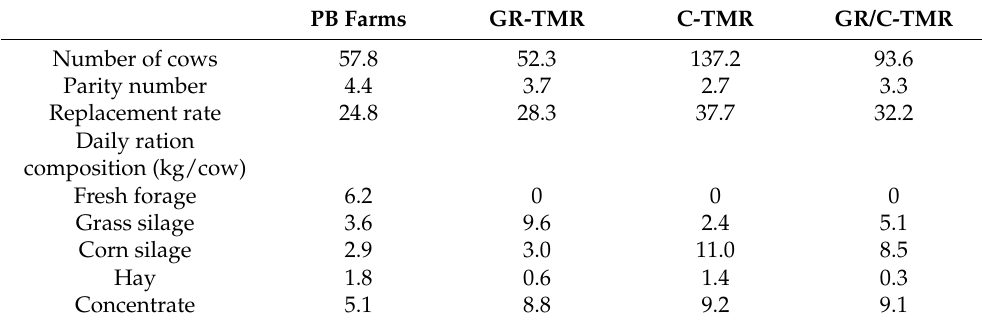
Table 1. Mean number of lactating cows, parity, replacement rate and ration composition of studied dairy farms (n = 25) in northwestern Spain according to type of forage used for feeding dairy cattle. PB Farms GR-TMR C-TMR GR/C-TMR Number of cows 57.8 Parity number